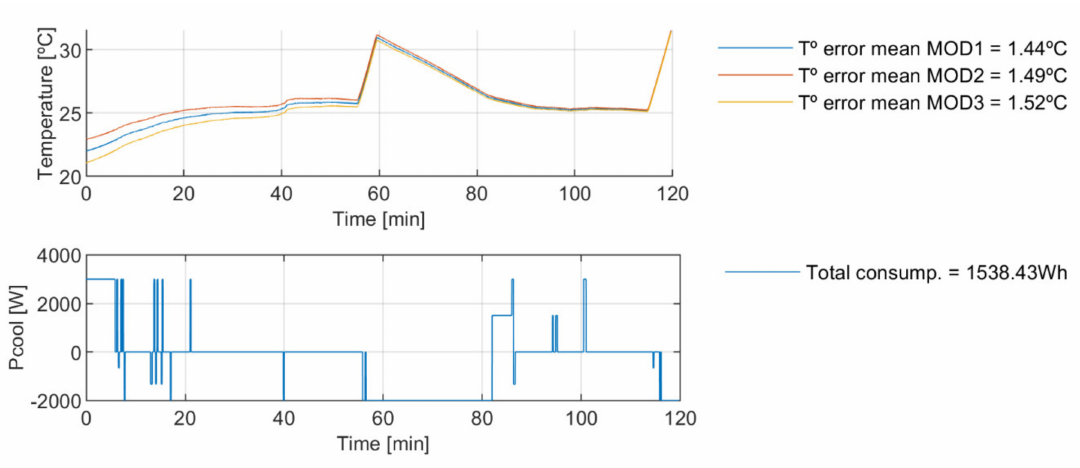
Figure 11. Use case simulation with the developed decision tree-based controller.